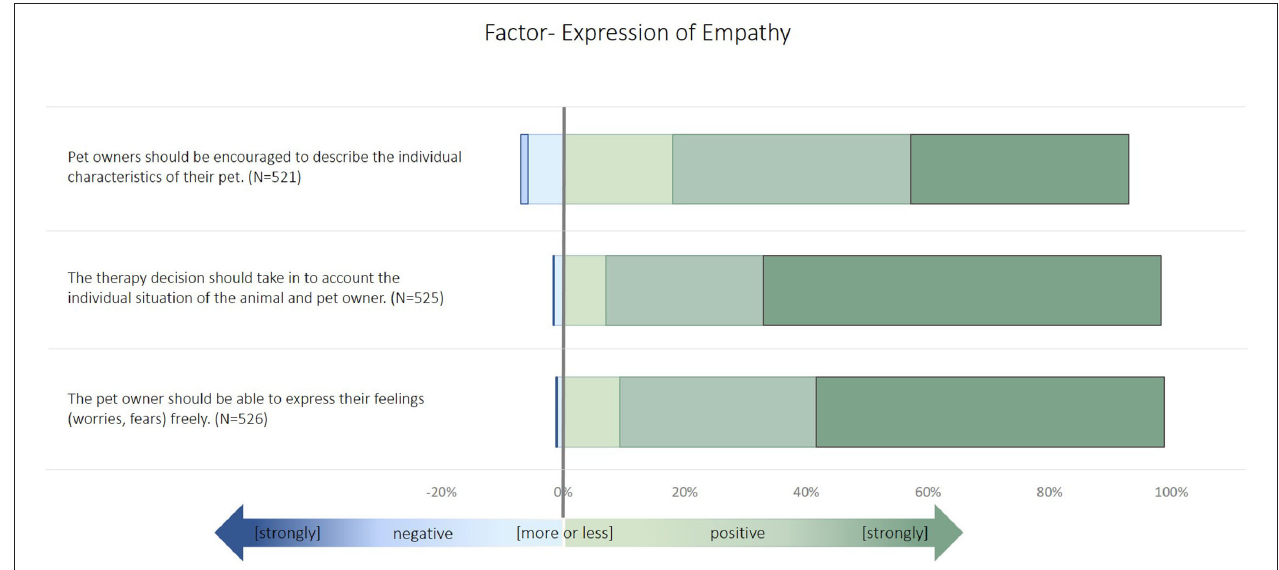
FIGURE 5 | Description of the questionnaire items in the survey on shared decision making taken by German